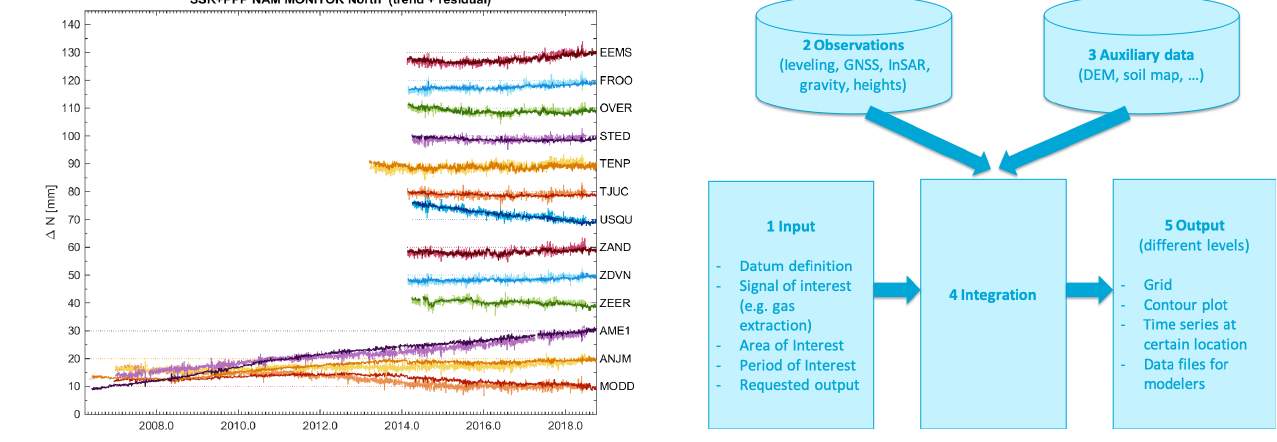
Figure 8. GNSS time series North component (relative, mm), PPP (light) and SSR (dark) solution.